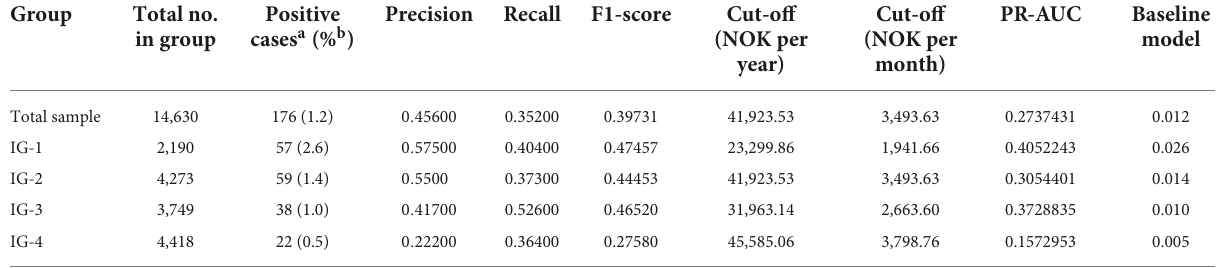
TABLE 3 Results from the precision-recall (PR) analyses when setting the threshold of classification at problem gamblers. Group Total no. Positive in group cases a (% b )